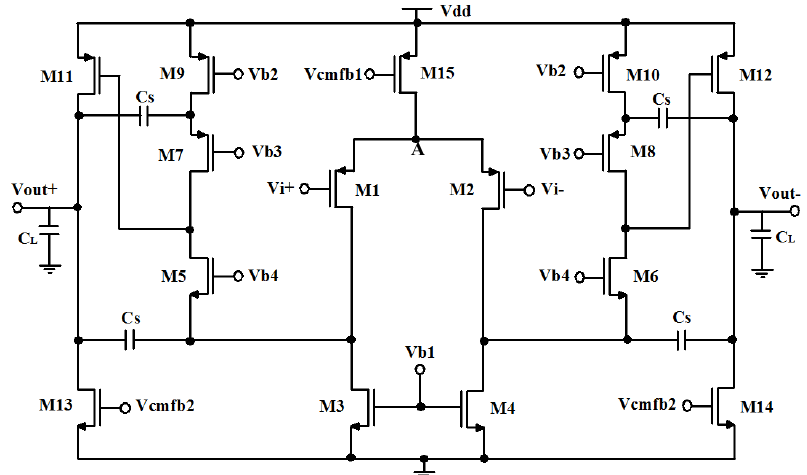
Figure 4. Folded-cascode operational transconductance amplifier (OTA) circuit.